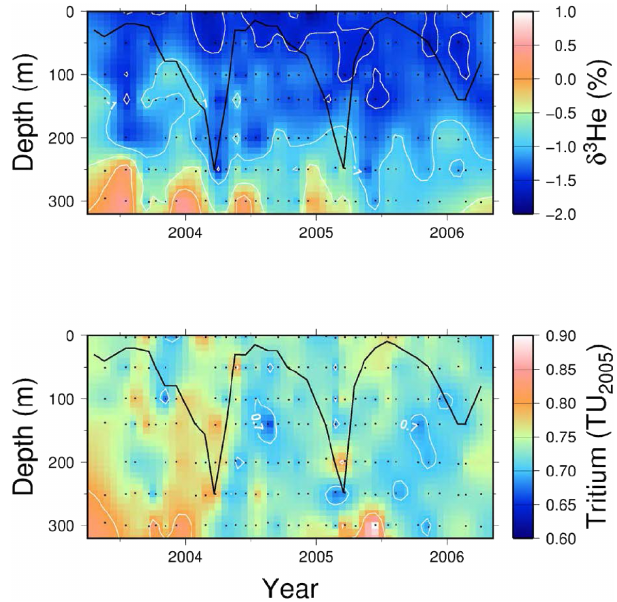
Figure 1. A time series of helium isotope ratio anomaly (in percent) relative to the atmospheric 3 He / 4 He ratio (upper panel) and tritium (in tritium units) decay corrected to January 2005 (lower panel) at the Bermuda Atlantic Time-series Site in the North Atlantic near Bermuda. Sampling, designated by black dots, was approximately monthly over the ∼ 3-year period. The black line is the mixed-layer depth estimated from the CTD (conductivity, temperature, depth)